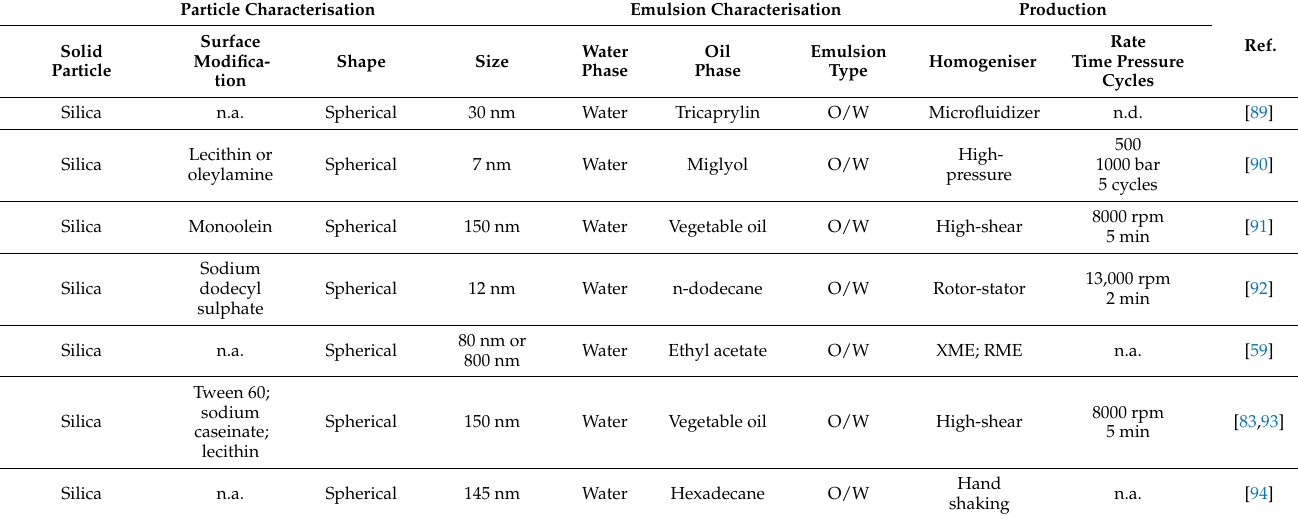
Table 1. Examples of PEs stabilised with inorganic food-grade